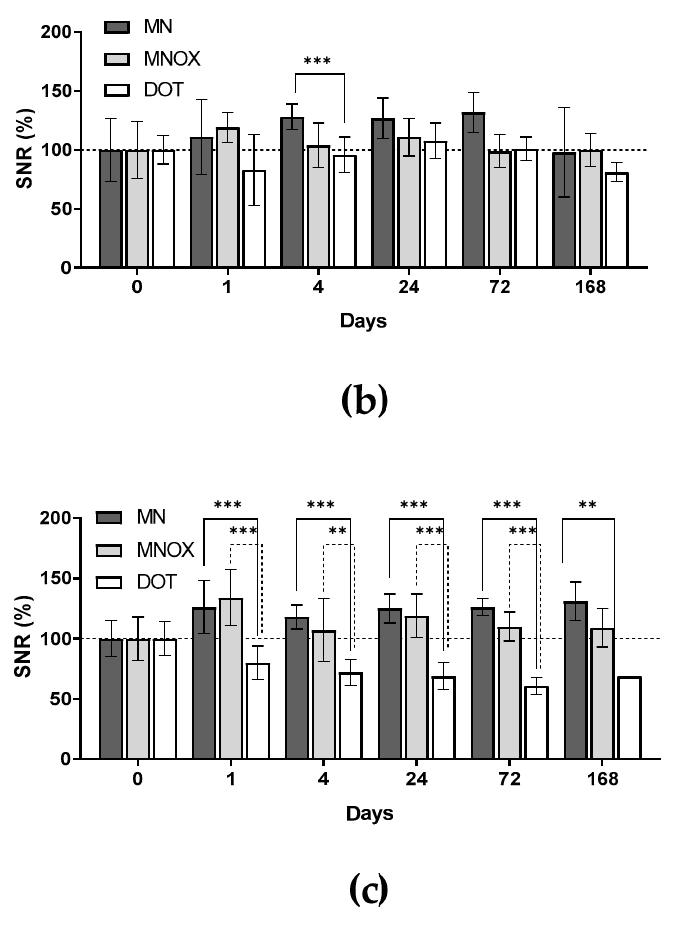
Figure 6. Quantification of MR measurements. Results are presented as the SNR percentage mean ± SD. Measurements performed before application of contrast agents are deemed 100%. Graphs show results from ( a ) inguinal lymph nodes on non-tumor sites, ( b ) inguinal lymph nodes on tumor sites (SLNs) and ( c ) tumors. The multiple one-tailed t-test was used for statistical evaluation (n = 9 for MN group, n = 9 for MNOX group and n = 6 for DOT group), p -values: *** p < 001, ** p < 0.01, * p < 0.05.